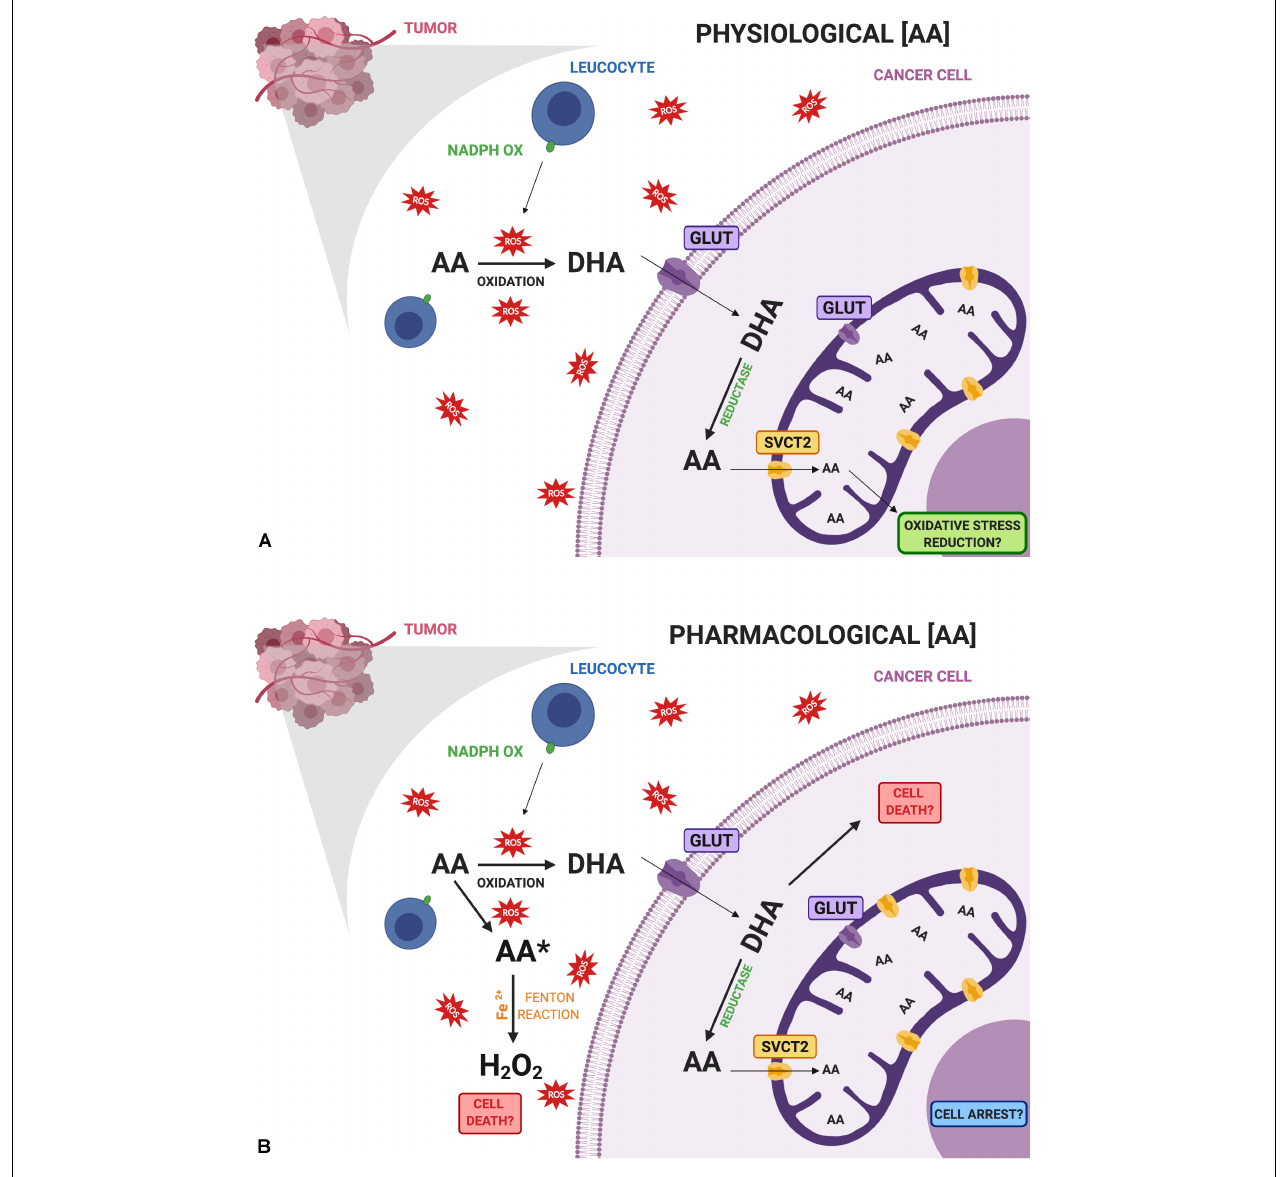
FIGURE 1 | Comparative diagram of vitamin C doses and its possible effects on cancer cells. (A) Physiological doses of ascorbic acid (AA) are oxidized with the help of activated leucocytes that are infiltrating the tumor, producing dehydroascorbic acid (DHA), which is the main form transported by cancer cells. Once inside the cell, DHA is rapidly reduced to AA where it can enter mitochondria via SVCT2 reducing oxidative stress at this level. (B) Pharmacological doses of AA may induce the production of ascorbate radical (AA*) and hydrogen peroxide (H 2 O 2 ) inducing cell death. On the other hand, increased amounts of DHA entering cancer cells through GLUTs may participate in cell death due to an increase in oxidative stress. Role of mitochondrial GLUTs must be further studied in cancer. Finally, intracellular vitamin C could contribute to cell arrest. All these events are related to the cytotoxic effects of vitamin C in cancer cells. Created with BioRender.com.